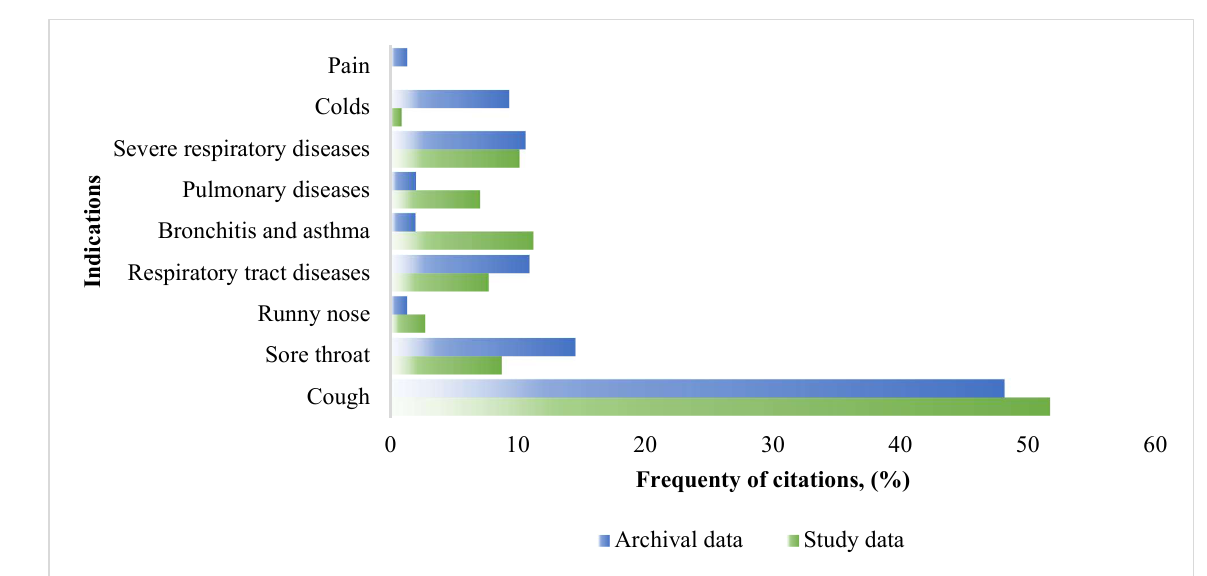
Figure 3. A comparison of the indications for use collected in ethnopharmacological research in the Pasvalys district and from the archival source . Severe respiratory diseases, pulmonary diseases, and respiratory tract diseases are the groups of diseases, named by respondents, but not specified.